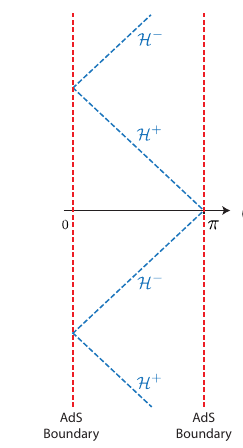
Figure 2 . Penrose diagram of the near horizon limit of the exterior region of an extremal black hole, which corresponds to the Poincare patch of AdS 2 . The boundaries are located at (cid:18) = 0 ; (cid:25) while the black horizon H (cid:6) at (cid:18) (cid:6) = (cid:25) . We have plotted several constant r curves in gray. To the right we have the maximal extension, corresponding to global AdS 2